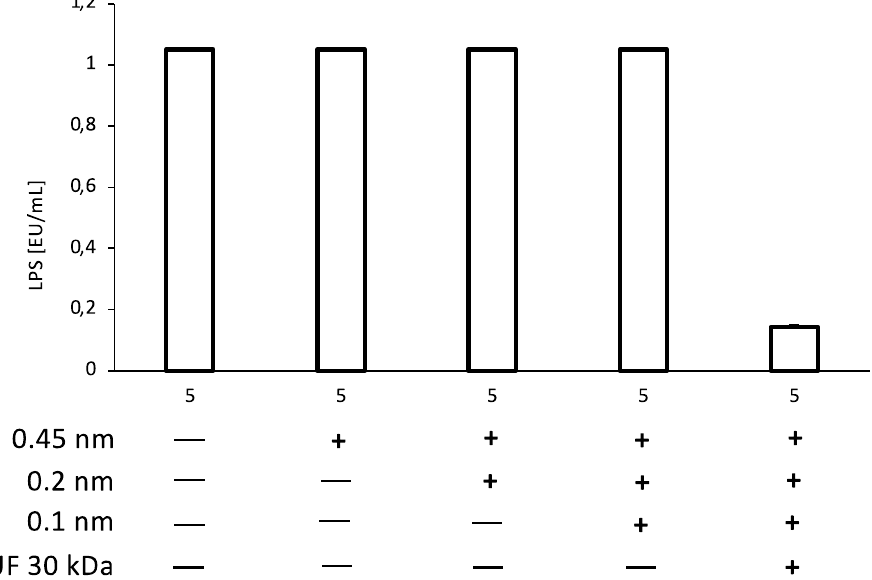
Figure 6. Influence of subsequent filtration steps on pyrogens content in extract 5 at the concentration of 50 μg/ mL. Analytical sensitivity: 0.1